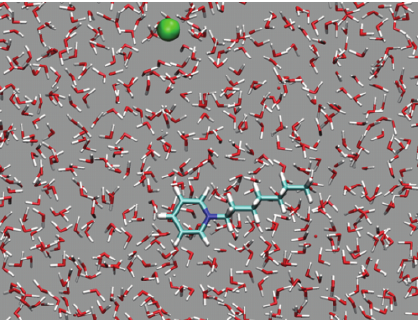
Figure 1: Initial configuration of the simulated system. Two coun- terions were located randomly in the water box. The cation was nonprotonated N-heptyl-pyridine, and the anion was chloride ion (in green).